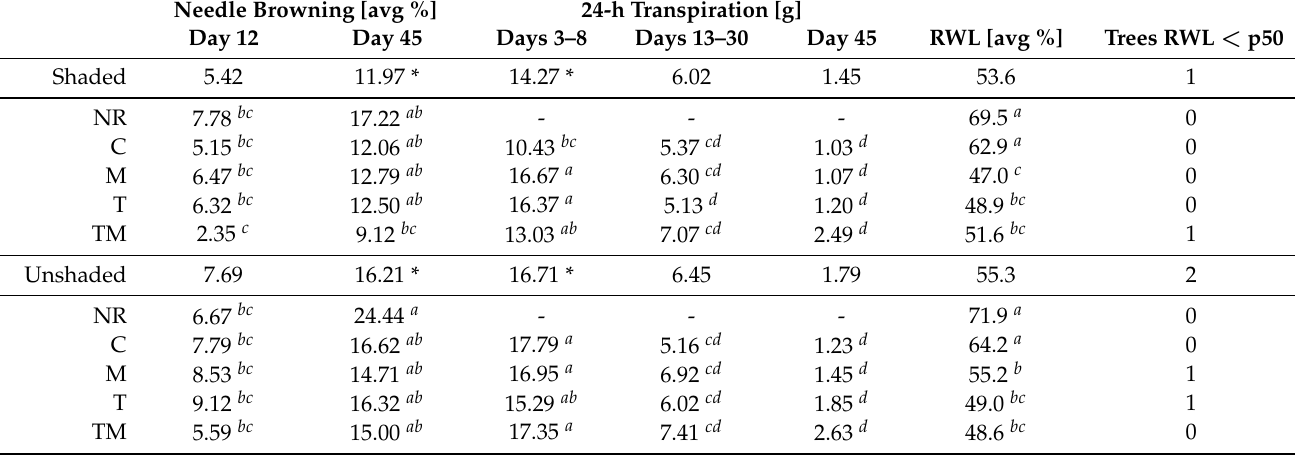
Table 2. Average needle browning [%], 24-h transpiration following watering treatments [g], relative water loss at the end of the experiment [RWL: %], and number of trees with RWL below the p50 value for experimental treatment groups (NR: no rain, C: control, M: +50% event magnitude, T: +50% timing, TM: +50% timing and magnitude) in shaded (47% canopy cover) and unshaded (1% canopy cover) microsites. Letters indicate statistically significant differences within the 10 shelter-treatment subgroups, and stars indicate statistically significant groupings between sheltered and unsheltered microsites, determined by ANOVA and Tukey’s honest significant differences ( p <